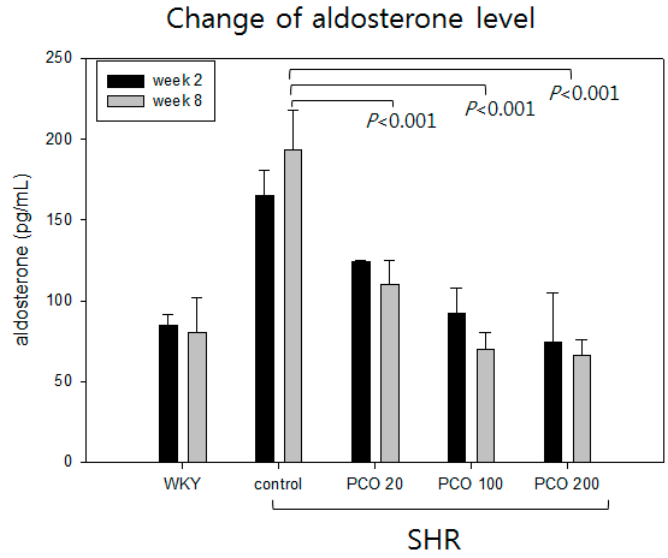
Figure 7. Changes in aldosterone level during eight weeks of policosanol consumption.